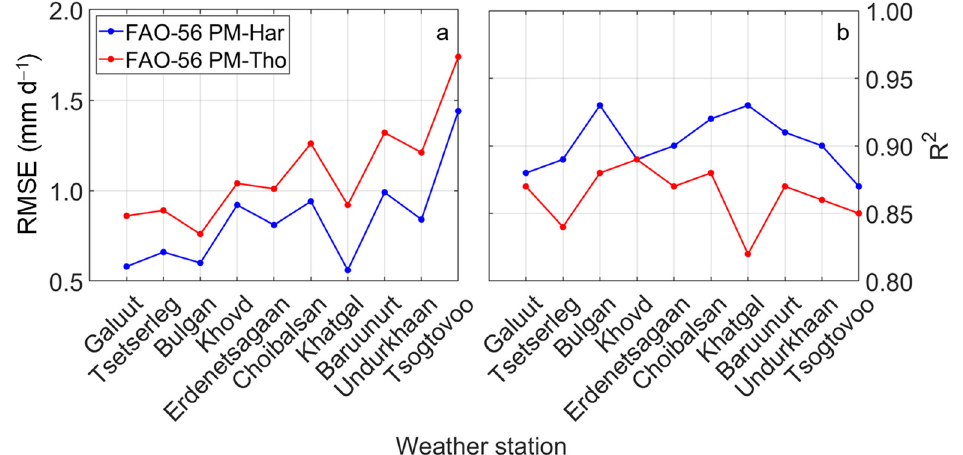
Figure 4. Model performance indicators comparing the FAO-56 PM with Har (blue line) and Tho (red line) to estimate daily values of ET 0 : ( a ) RMSE (mm d − 1 ) values and ( b ) values of R 2 (-) for 10 weather stations.